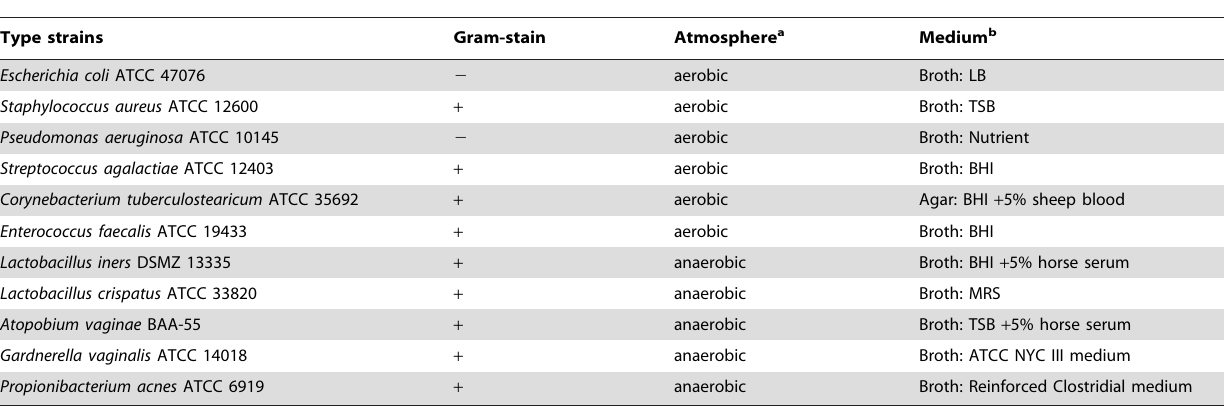
Table 2. Bacterial strains and cultivation condition